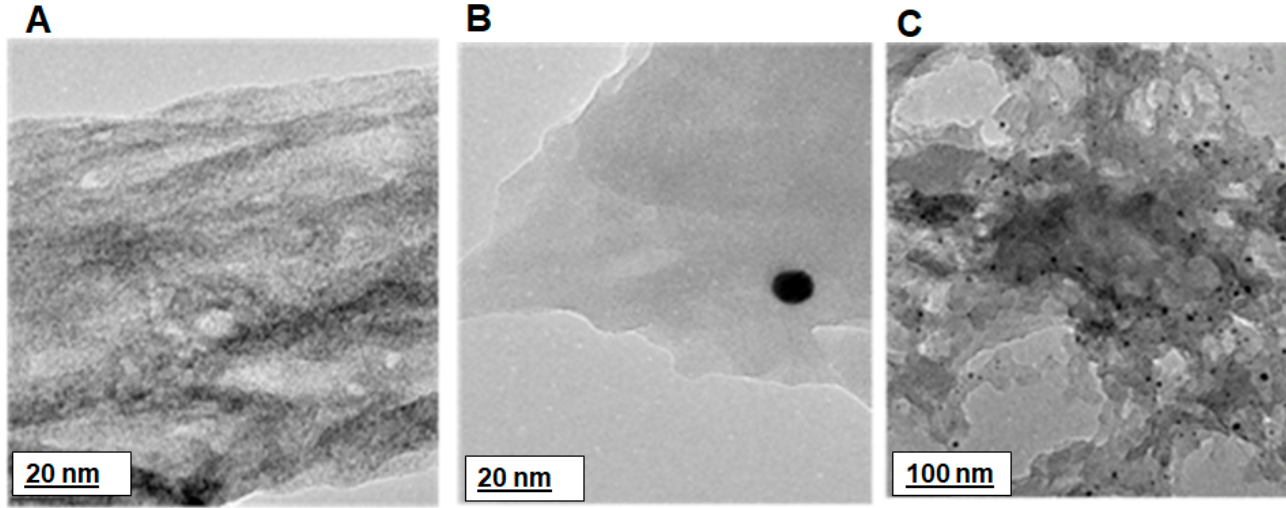
Figure 6. HRTEM images of ( A ) PDMA–PVS at 20 nm scale view; and PDMA–PVS–Ag 0 nanocomposite at ( B ) 20 nm and ( C ) 100 nm scale views.